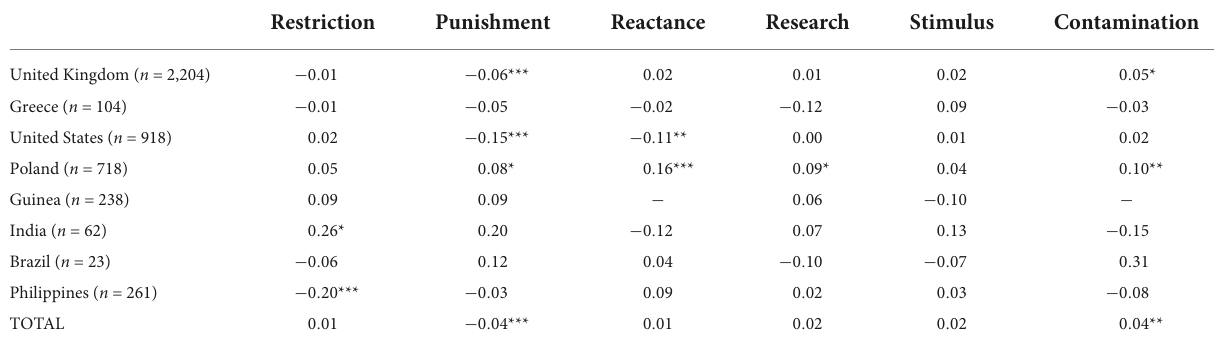
TABLE 2B The relationship of age with government response across nations. Nation Measure Restriction Punishment Reactance Research Stimulus